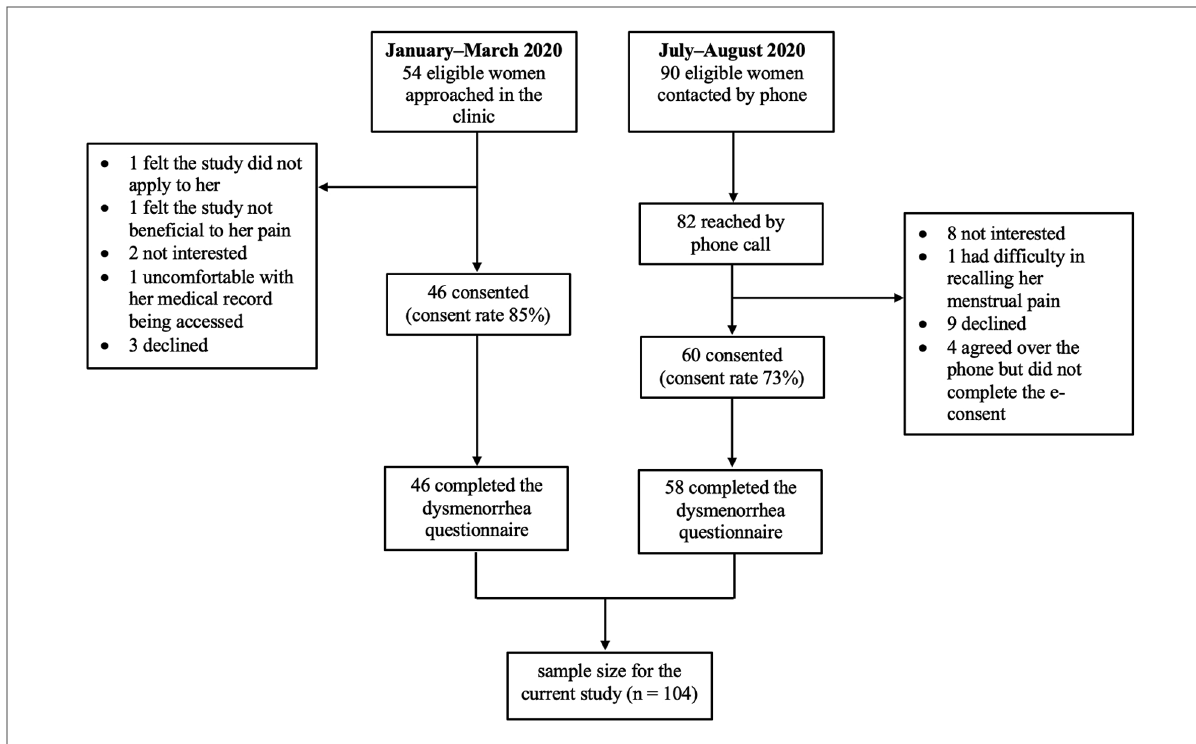
FIGURE 1 Flow chart of recruitment of the study